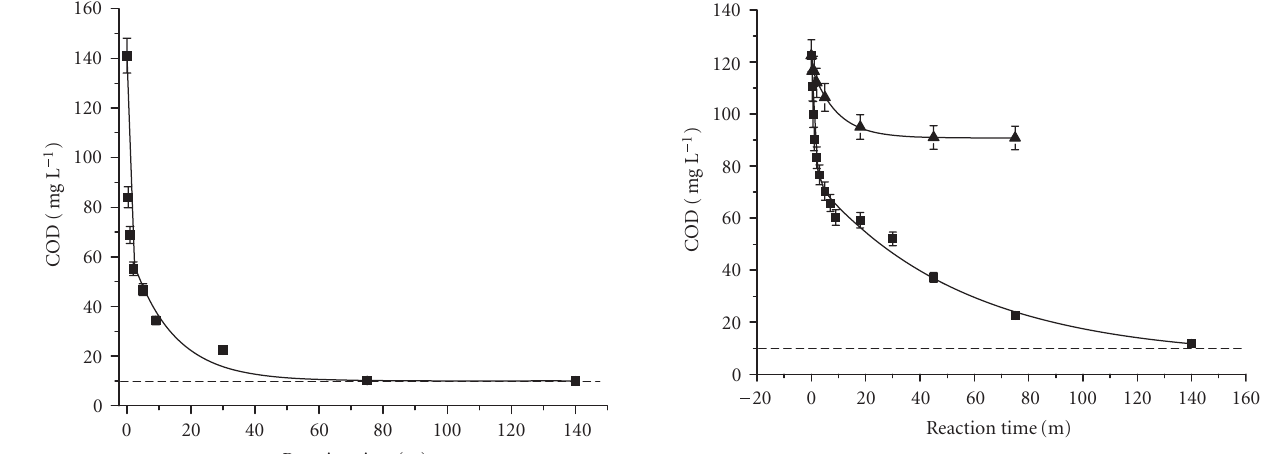
Figure 7: COD abatement of a solution of 0 . 267 mmol L − 1 alachlor as a function of solar irradiation time in the presence of TiO 2 . The best fit (—) of the experimental data ( (cid:2) ) was for an exponential decay second-order equation. The dashed line represents the deter- mination limit of COD method.